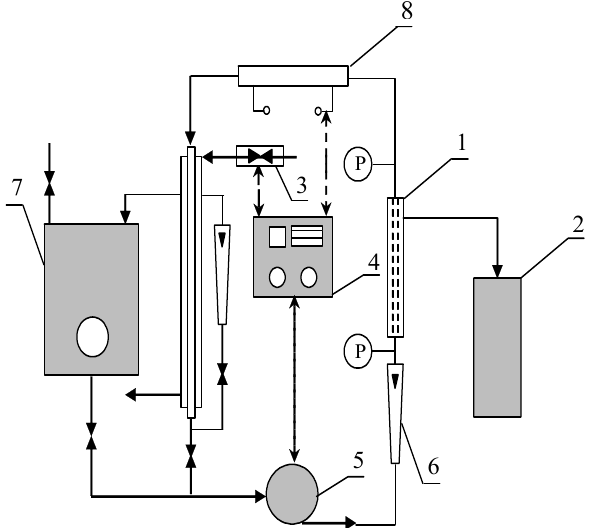
Figure 1. Experimental set-up of the cross-flow microfiltration (MF) unit. 1—MF module, 2—measuring cylinder, 3—heat exchanger, 4—controller of temperature and flow rate, 5—pump, 6—rotameter, 7—feed tank, 8—heater, and P—manometer.